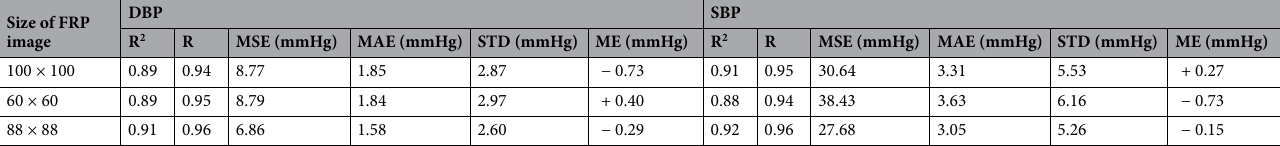
Table 5. Accuracy evaluation of the different sizes of 2-D FRP images in the Concat_CNN model in terms of all metrics for DBP and SBP